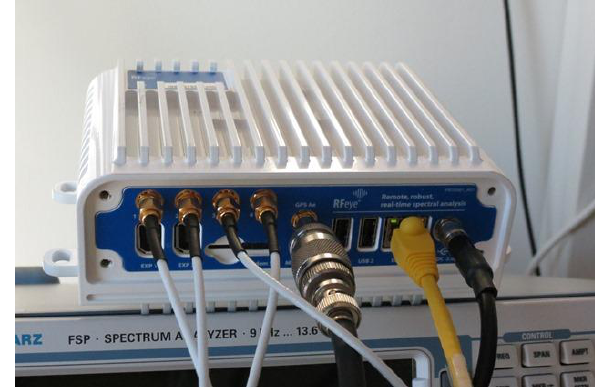
Figure 2. CRFS RFeye spectrum monitoring node